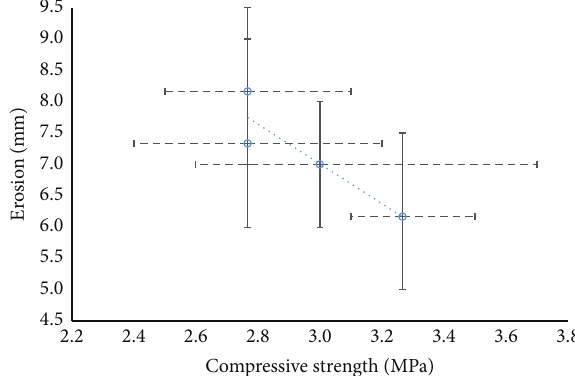
Figure 14: Correlation between erosion and compressive